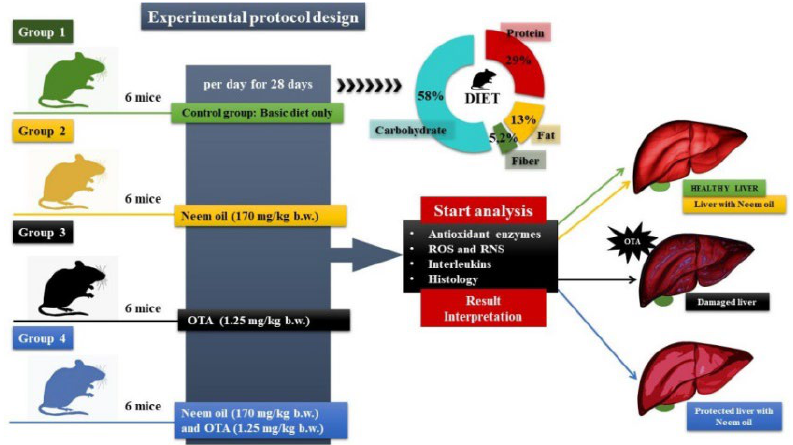
Scheme 1. Experimental protocol design .